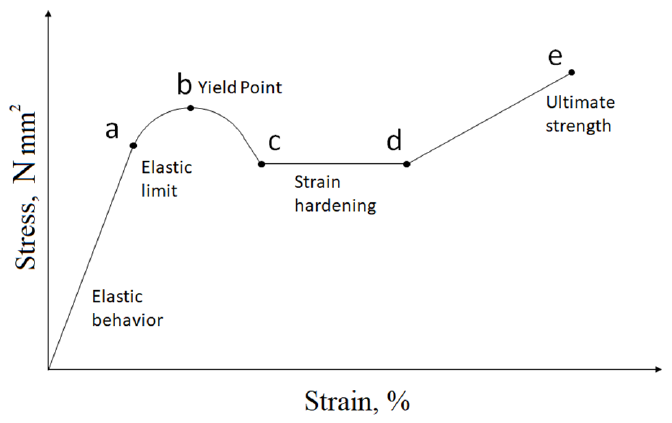
Figure 3. Dependence of strain on stress for glassy polymers [22].